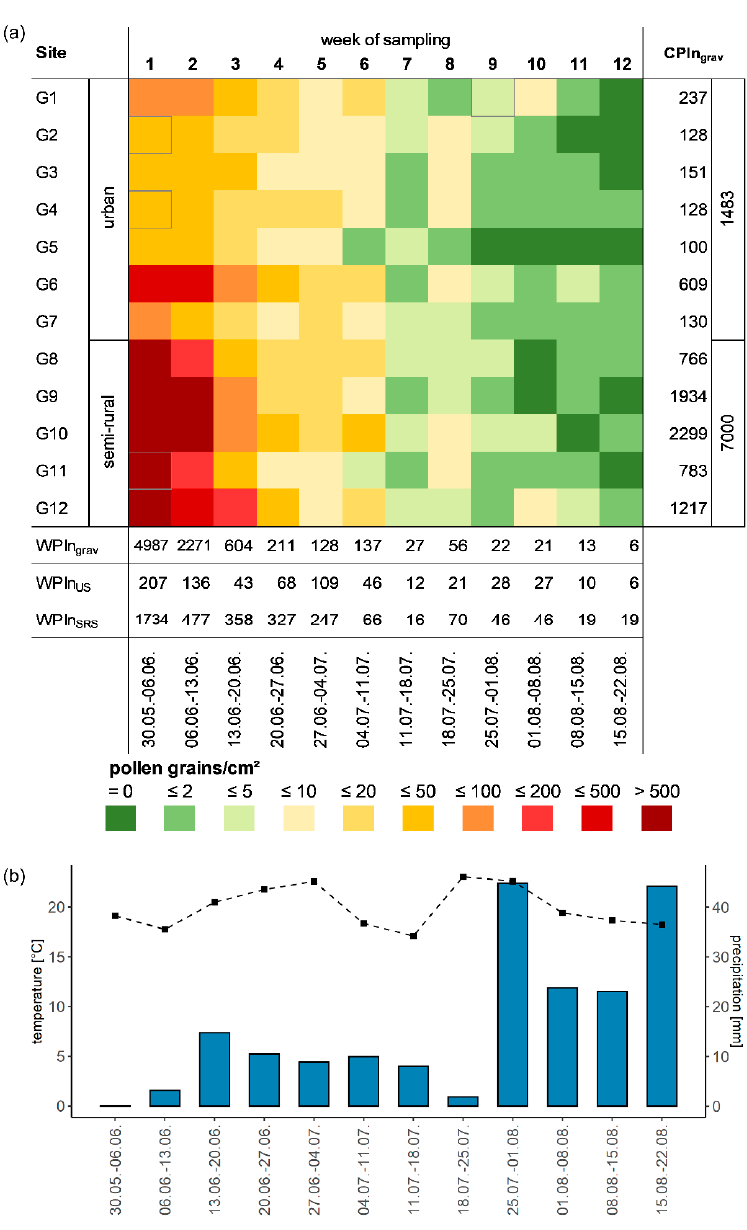
Figure 4. ( a ) Heat map showing weekly grass pollen deposition (pollen grains/cm 2 ) in 2019 for the sampling campaign figure 30 May to 22 August 2019 and WPIn US and WPIn SRS for the respective weeks. Gravimetric traps are ordered by distance from the urban station (US). A grey outline indicates interpolated values. ( b ) Weekly mean temperature (black squares/dotted line) and weekly sum of precipitation (blue bars) during the sampling campaign with gravimetric traps from 30 May to 22 August 2019. During sampling, mean temperature was 19.9 °C, and precipitation sum was 193 mm (Figure 4b). There was no week without precipitation. In the week with the highest WPIn grav , we recorded 1 mm of rain. During sampling, the wind came predominantly from